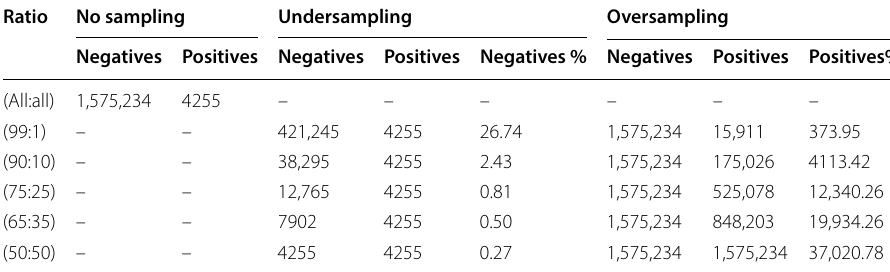
Table 2 SlowlorisBig sampling Ratio No